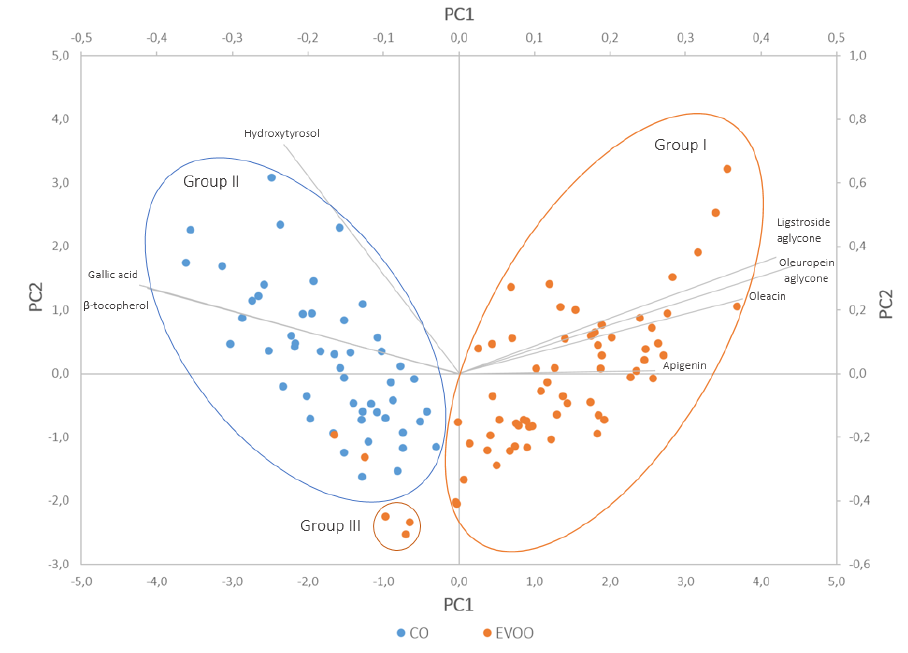
Figure 3. Bi-plot comparing scores along with loadings.